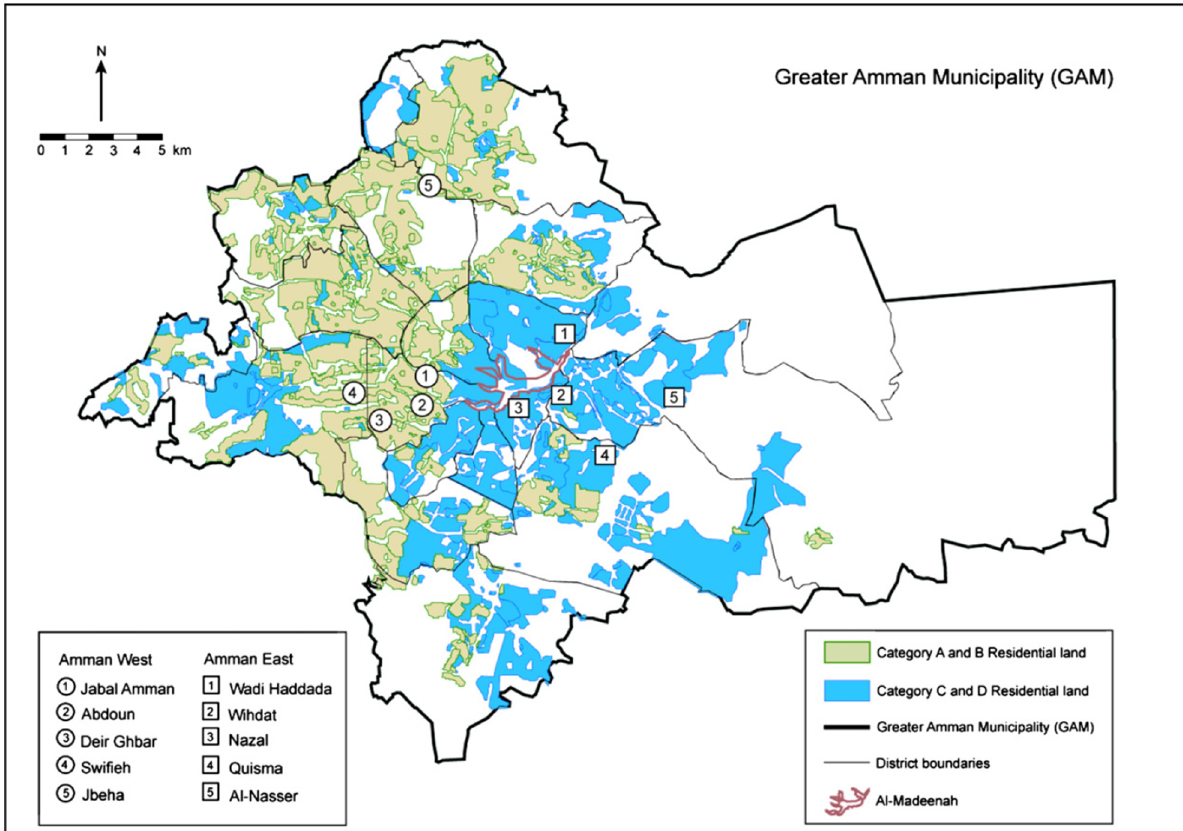
Figure 2. Greater Amman map analyzed to determine income class distributions across districts (Reprinted from [38], Copyright 2009, with permission from Elsevier). The image shows residential land areas used to determine two different income classes in Potter and Darmame [28]. The beige areas indicate high-value and the blue areas low-value residential land, which the authors successfully used to identify respondents from different income groups for their